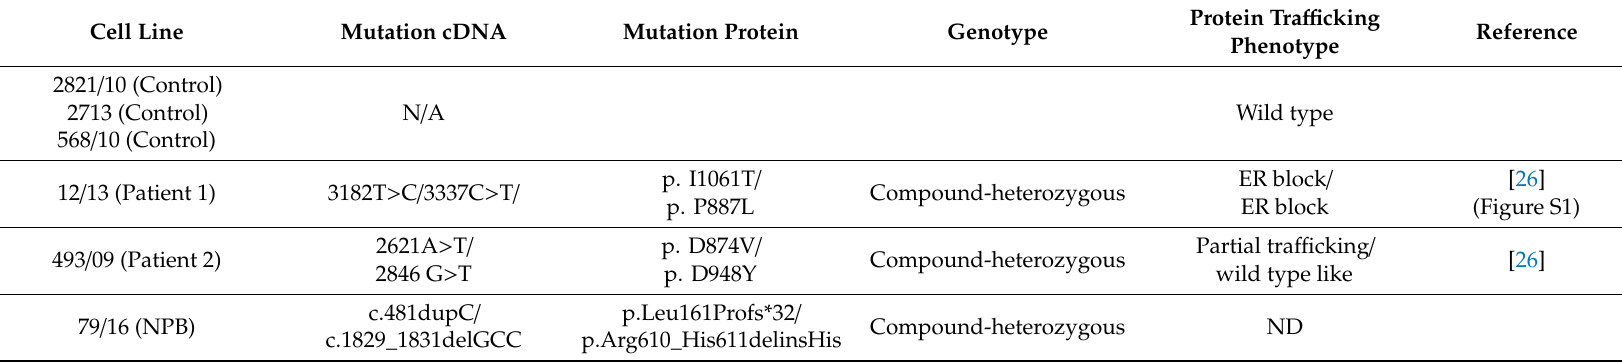
Table 1. Compilation of the fibroblast cell lines from controls and patients, the corresponding mutations, genotypes and protein tra ffi cking